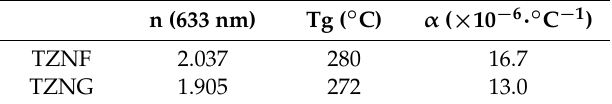
Table 1. Principal properties of the core and cladding glasses used for built-in-casting.